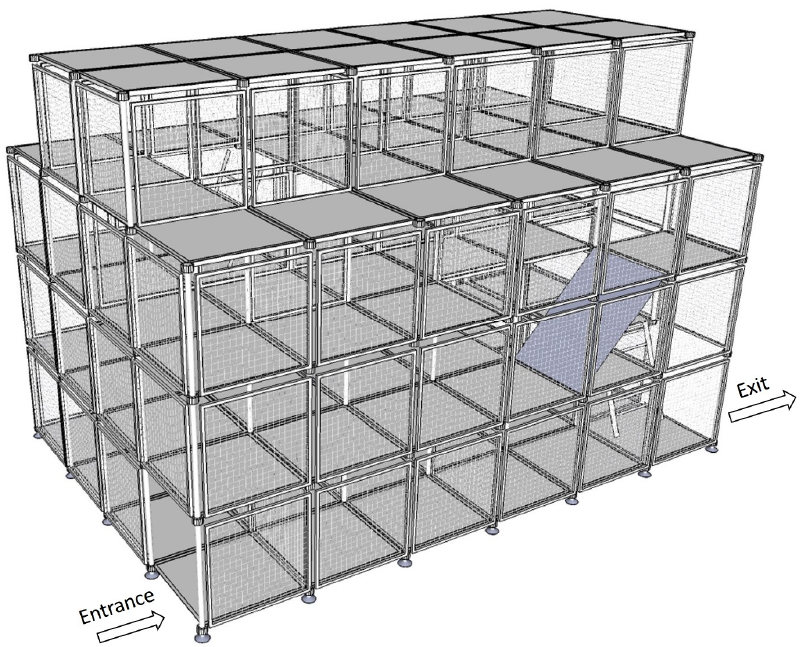
Figure 1. Perspective view of the DCEs.